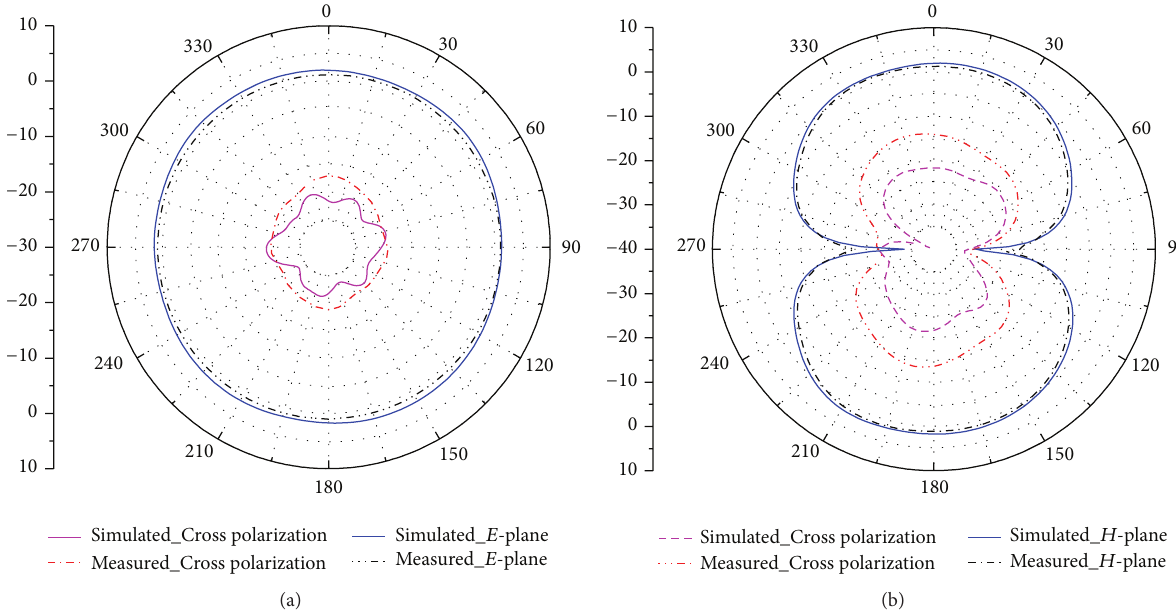
Figure 11: Simulated and measured radiation pattern. (a) 𝐸 -plane. (b) 𝐻